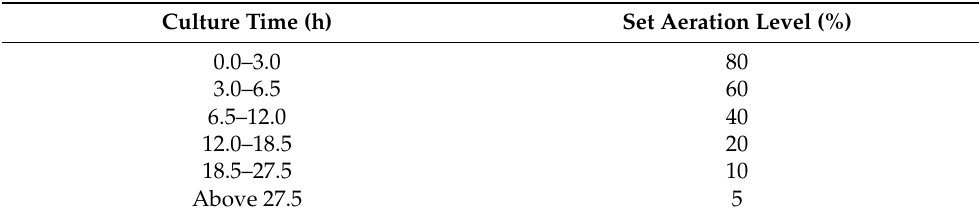
Table 2. Medium aeration profile of the fifth culture applied in the current